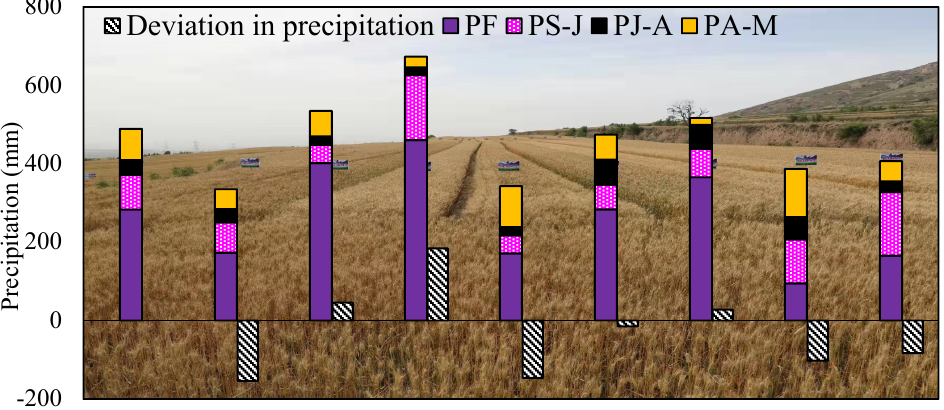
Figure 1. Location of experiment site in the Loess Plateau. The regional distribution of annual precipitation is shown in different colors on the map.